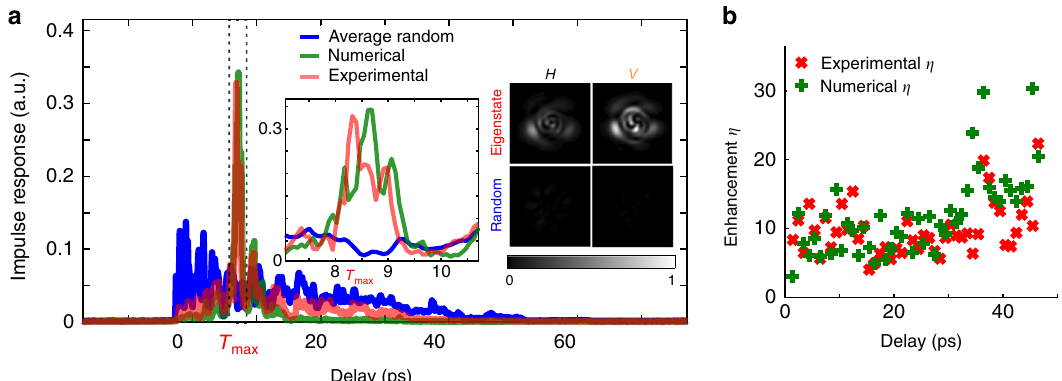
τ max ; Reconstructed output intensity at η for different